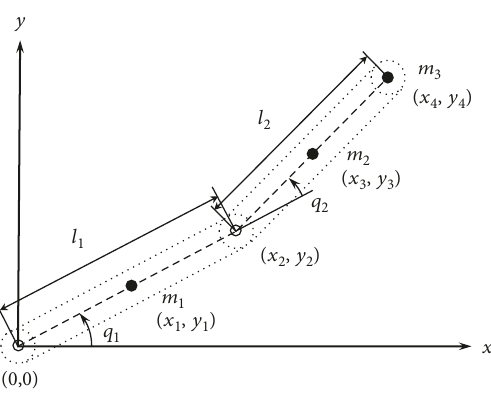
Figure 2: Schematic diagram of the 2-DOF SCARA robot.